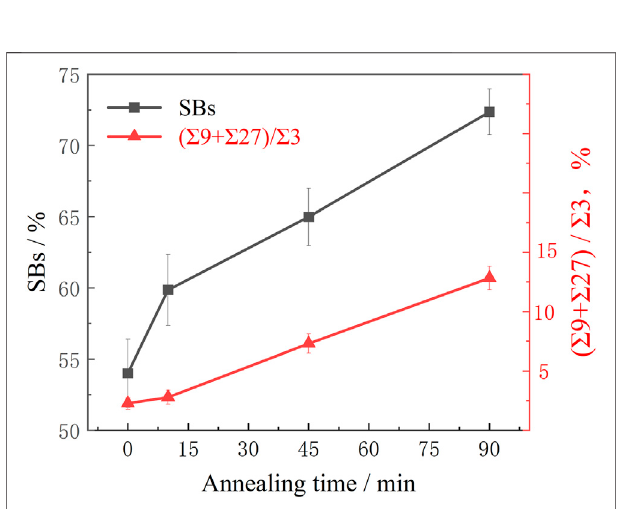
FIGURE 4 | The curves of the SBs ’ ( Σ 1 – Σ 29) percentages and the ( Σ 9 + Σ 27)/ Σ 3 ratios.